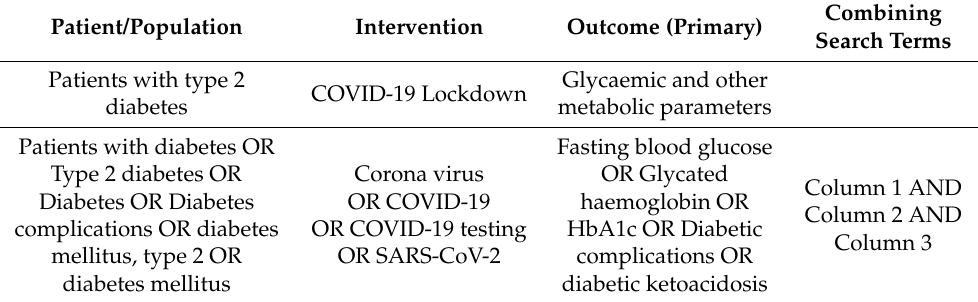
Table 1. Search Terms and Search